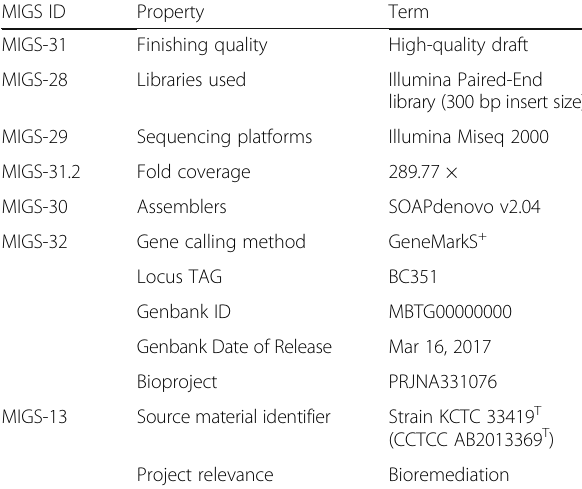
Table 4 Number of genes associated with general